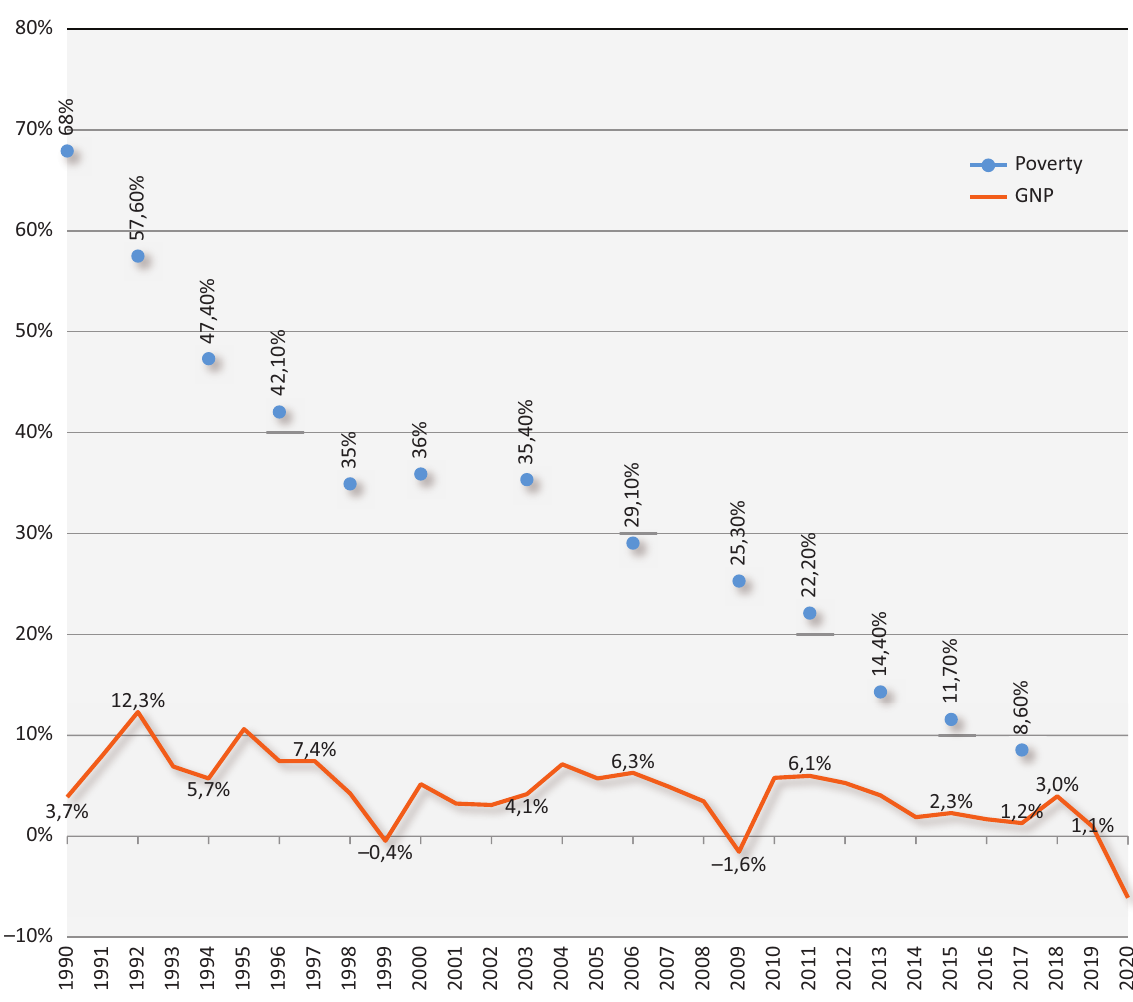
Figure 1. Evolution of poverty and Gross National Product (GNP) in Chile (%), 1990–2020. Source: Own elaboration with data from Ministerio de Desarrollo Social (2017) and World Bank